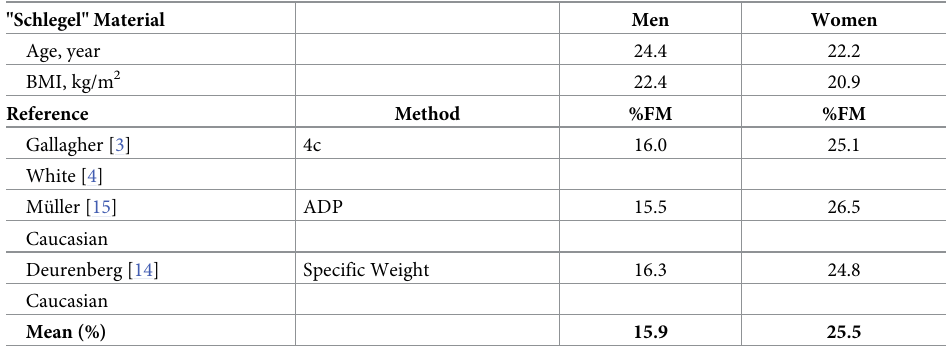
Table 1. Assignment of %FM to the "Schlegel" material, derived from different formulas of Caucasian cohorts. "Schlegel" Material